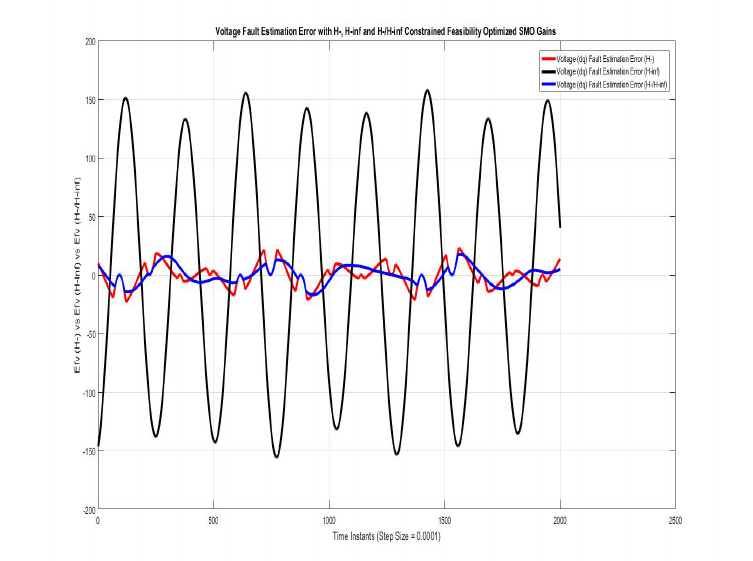
Figure 6. Voltage fault estimation error with feasibility optimized H − and H − / H ∞ SMO gains.